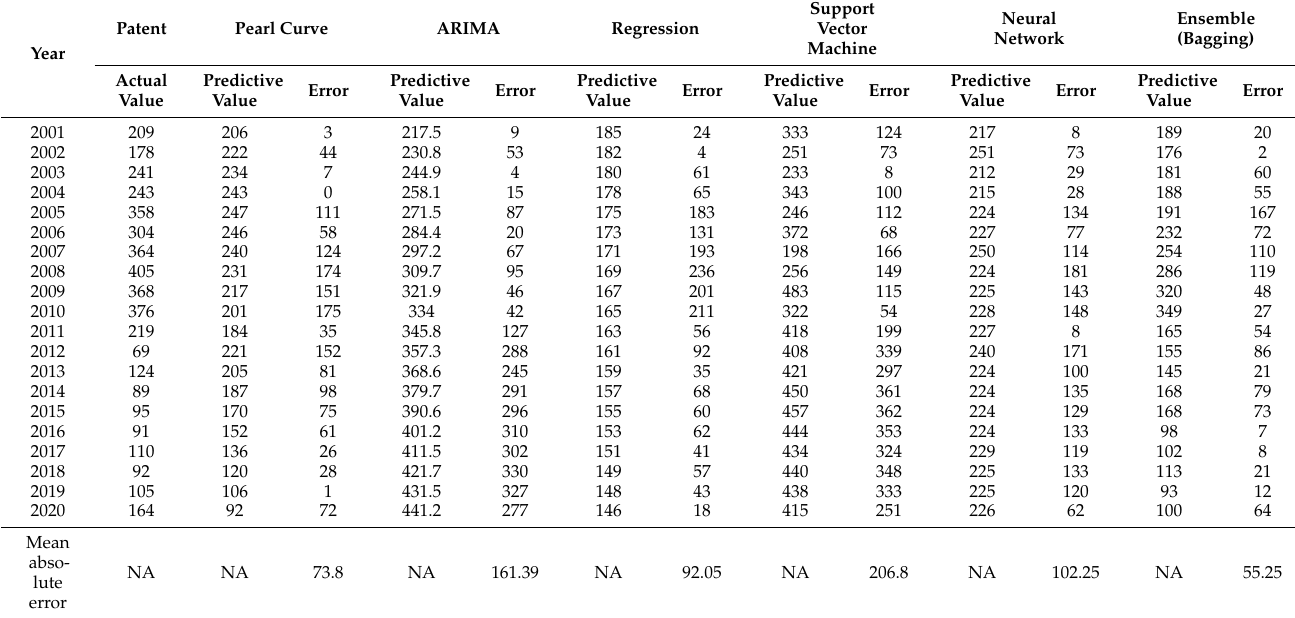
Table 3. Predictive performance and absolute error of global body